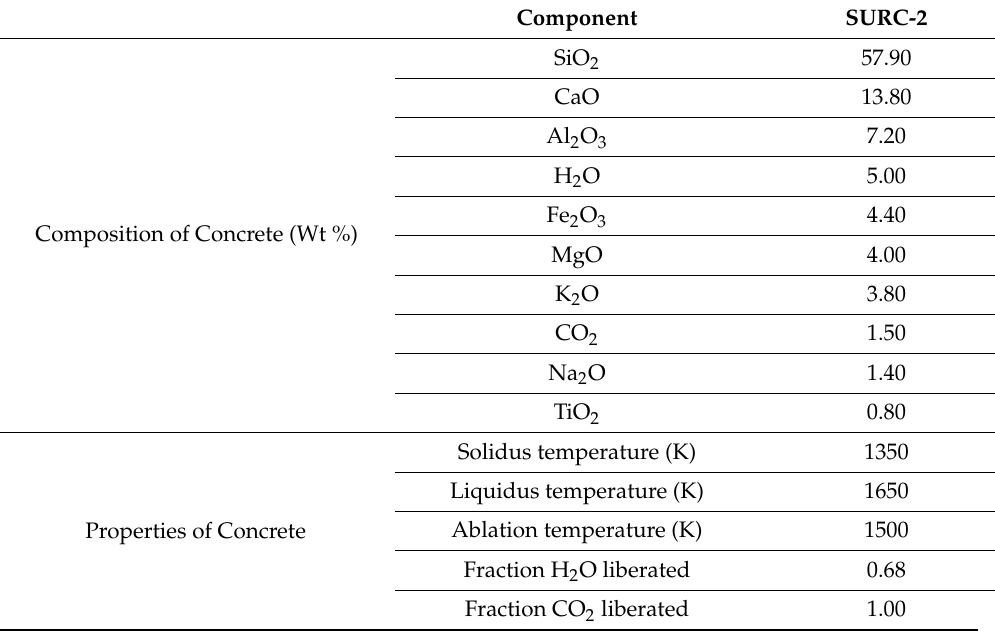
Table 5. Concrete composition and its properties for